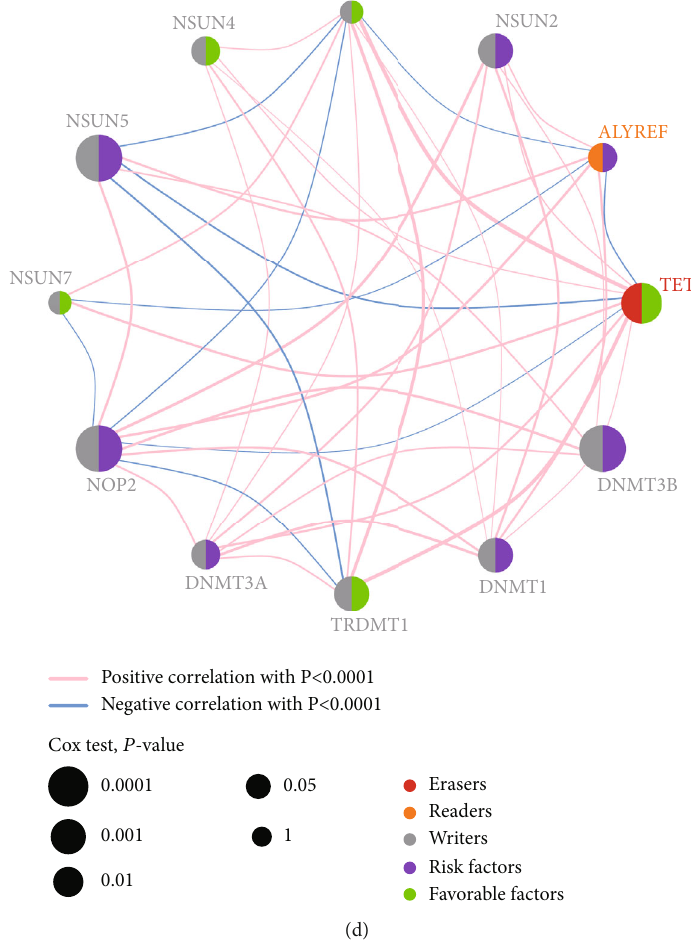
Figure 3: PPI network and correlation analyses of m 5 C RNA methylation-related genes. (a) PPI network of the eleven di ff erentially expressed m 5 C RNA methylation regulatory genes. (b) Correlation analysis at the transcriptional level. (c) Pearson ’ s correlation analysis of these m 5 C RNA methylation-related genes in the TCGA. Note: ‘ r ’ denotes Pearson ’ s correlation coe ffi cient whose value ranges between -1 (perfect negative correlation) and +1 (perfect positive correlation). (d) A network plot of the function and correlation analysis by Cox